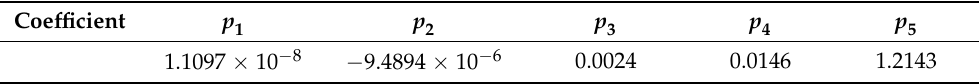
Table 4. Empirical formula coefficient of the characteristic curve.